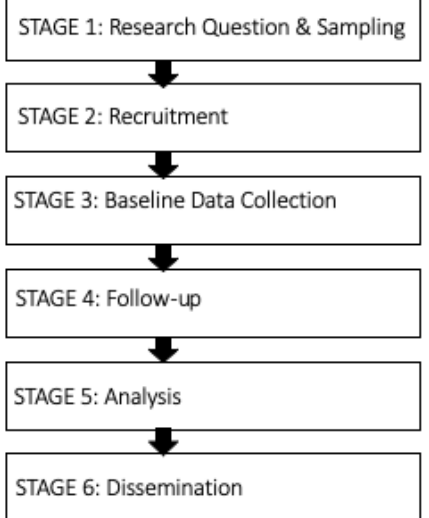
Figure 1. Core stages in the life cycle of a cohort